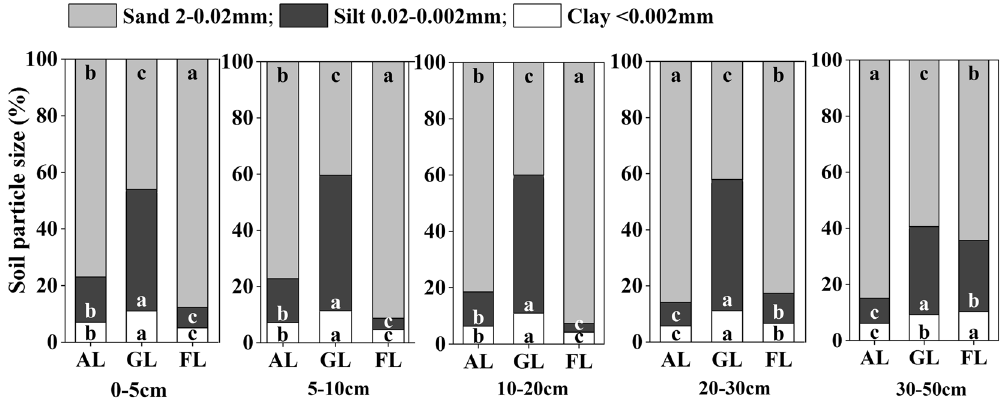
Figure 1. Soil particle size among different land uses at 0-50 cm depth. Different letters with the same particle size at the same soil depth indicate significant difference (n = 5, p < 0.05) among different land uses by one-way ANOVA.